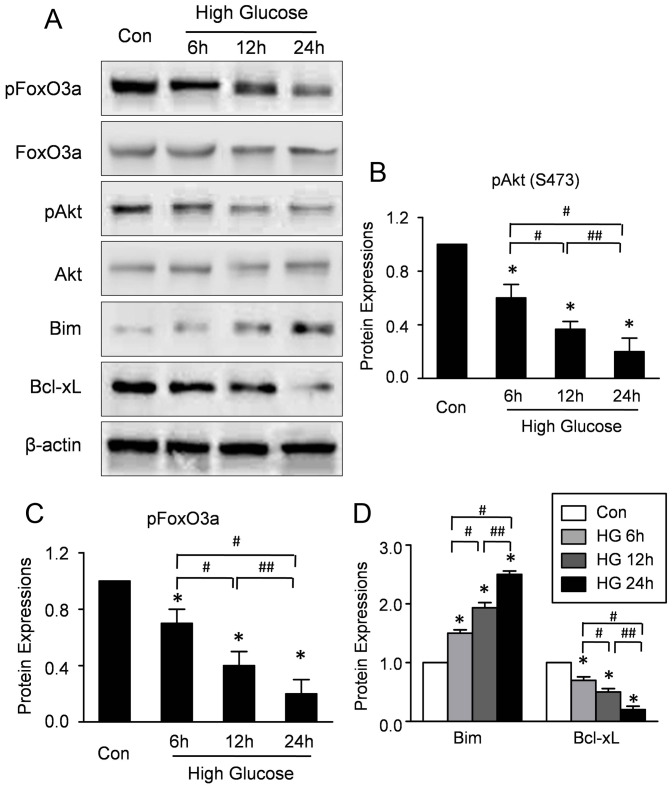
High glucose increases the activations of Akt and FoxO3a in CMECs.A: Representative Western blots of Akt, pAkt, FoxO3a, pFoxO3a, Bim and Bcl-xL in CMECs incubation with high glucose condition for the indicated time points. B: Semiquantitative analysis of the expressions of pAKt (B), pFoxO3a (C), Bim and Bcl-xL (D) at the indicated time point. (n = 5, *p<0.05 vs. Control, #p<0.05 vs. High glucose for 6 h, ##p<0.05 vs. High glucose for 12 h).